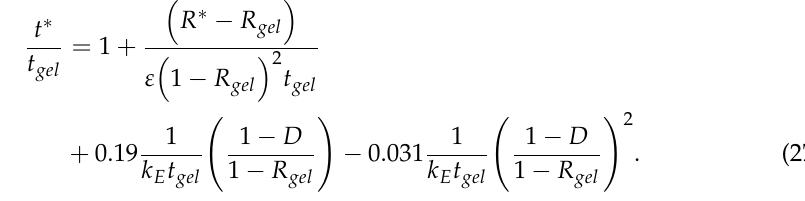
Equation (27) shows that t ∗ / t gel is linearly dependent on 1/ t gel and thus C 2 From the theoretical predictions of t ∗ and t gel , we can find that t ∗ − t gel is independent of the seed concentration. This may suggest that the micro-structural “shuffling” process is only determined by the stoichiometric ratio of the reactants and independent of the reactant concentrations.